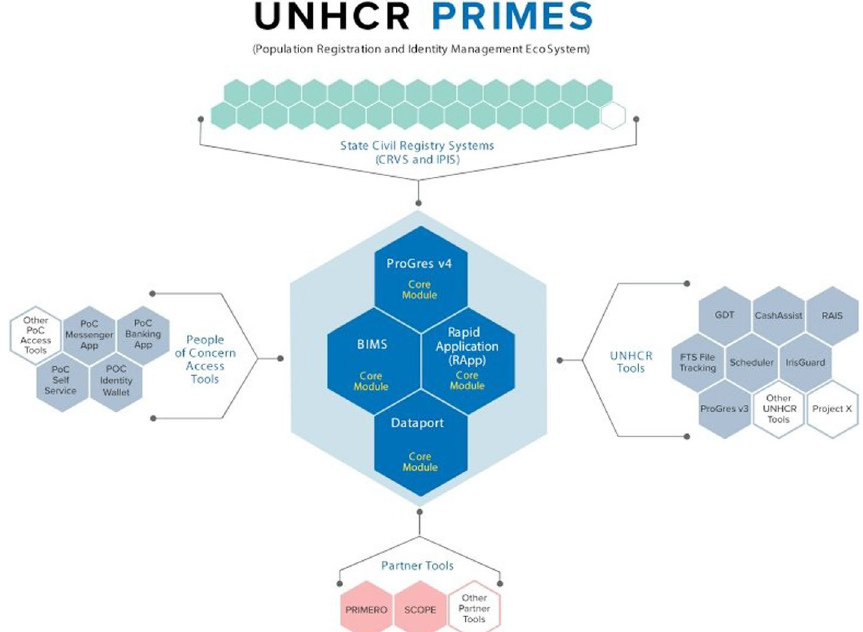
Fig. 3 UNHCR’s Population Registration and Identity Management EcoSystem (PRIMES) ( Source : UNHCR,